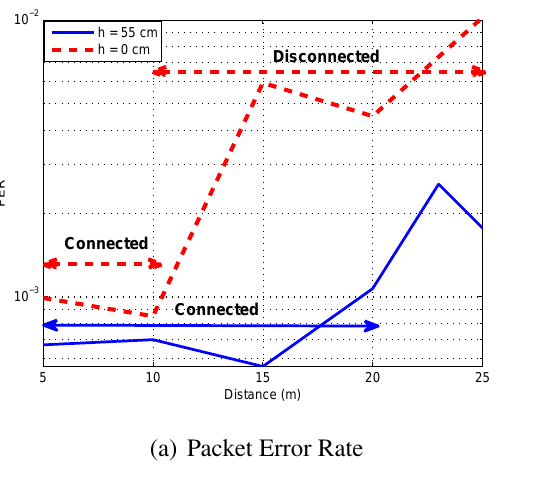
Figure 6. PER and RSSI against distance for two mote heights. Office